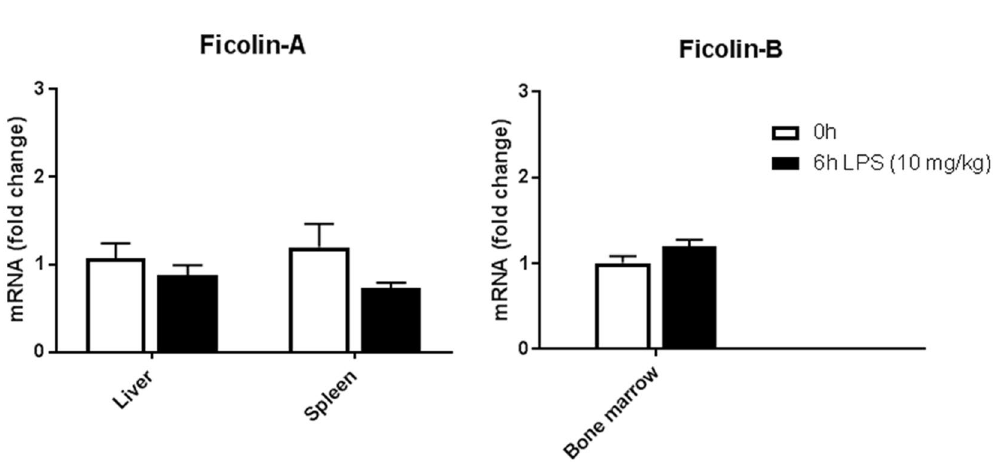
Figure 2. Survival and body weight change is similar in WT and ficolin KO mice after LPS challenge. WT and ficolin KO mice were intraperitoneally injected with LPS of indicated doses and monitored for survival ( A ) and body weight change ( B ) for 7 days. Results were obtained from one (5 mg/kg and 2.5 mg/kg; n = 8) or two (25 mg/kg and 10 mg/kg; n = 15) experiments. In A, Kaplan–Meier survival curves were compared using the log-rank test. In B, graphs show mean ± SEM.